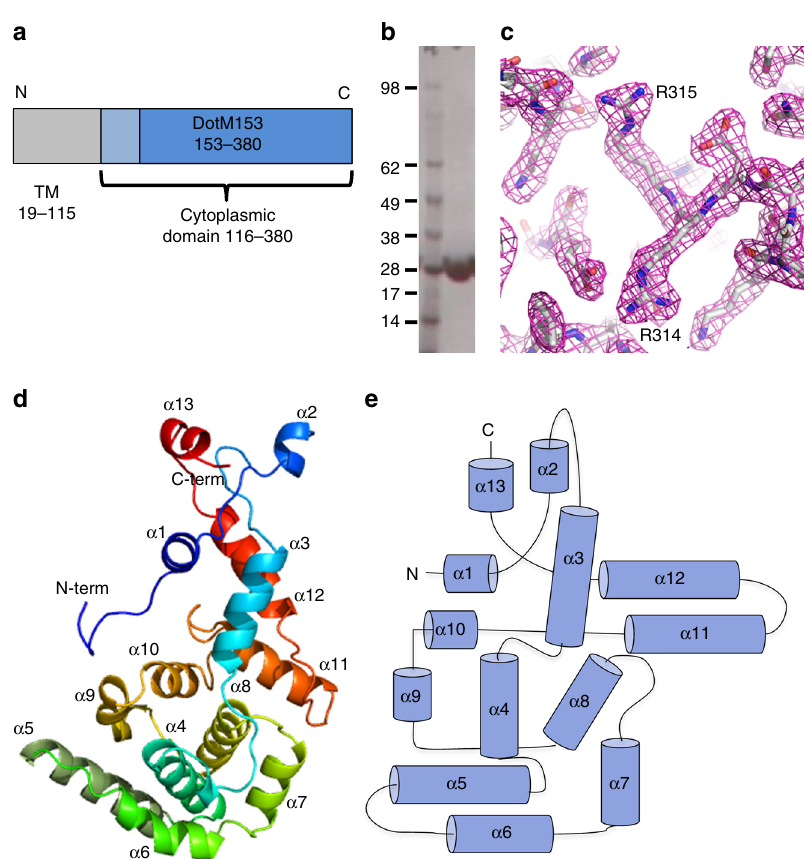
Fig. 1 DotM153 characterization and structure. a Domain organization of DotM. Residues 19 – 115 are predicted to form three transmembrane helices. The cytoplasmic domain (116 – 380) and the stable DotM153 fragment are shown in light and dark blue, respectively. b Puri fi cation of DotM153. A single band of DotM153 was observed in the SDS-PAGE analysis of the puri fi ed protein. Molecular weight markers (kDa) are shown in lane at left. Full gel fi gures are available in Supplementary Figure 3. c Experimental SAD electron density map of the DotM153 calculated at a resolution of 2.15 Å and contoured at a 2.0 σ level. The map is in wire representation colored in magenta. The re fi ned model built into the electron density is shown in stick representation, color-coded by atom type with C, O, and N atoms in gray, red and blue, respectively. Residues Arg314 and Arg315, participating in effector binding, are labeled. d Cartoon diagram representation of the crystal structure of the DotM153 monomer. The structure is rainbow colored and its 13 helices are labeled α 1 – 13. The N and C termini are indicated. e Topology diagram of DotM153. Helices are shown as cylinders and labeled α 1-13. N- and C-termini are